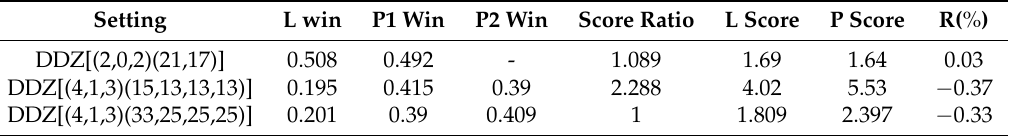
Table 9. Possible scores of landlord and peasant in different game settings. Setting L win P1 Win